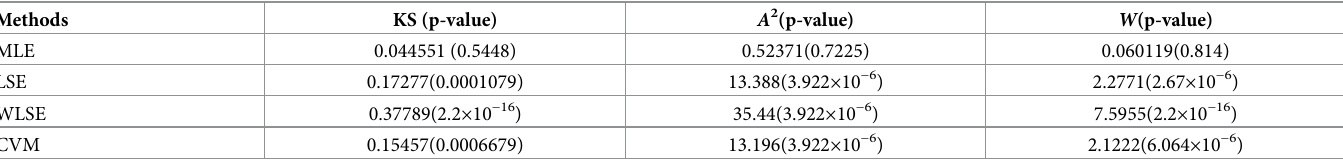
Table 5. Comparison with a p-value of KS, A 2 and W statistics in different methods. Methods